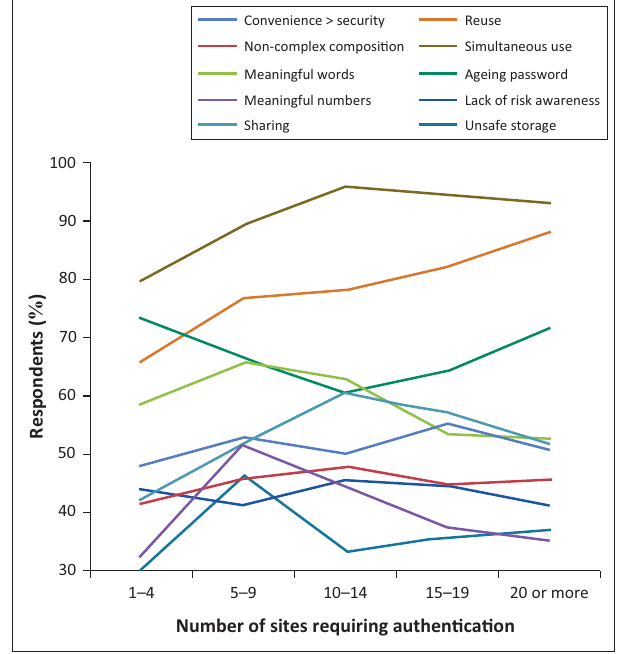
FIGURE 5: Weak password practices per number of sites requiring